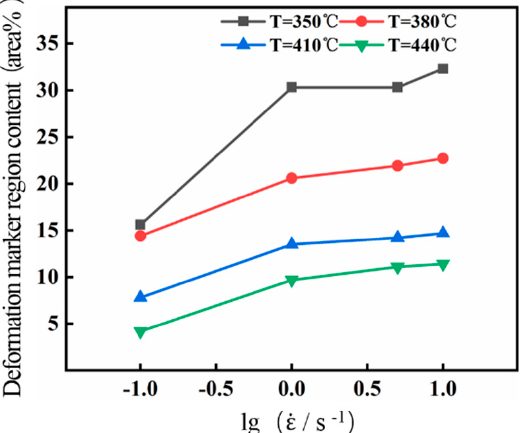
Figure 12. Statistics of the percentage of deformation marking area in the semi-solid CuSn10P1 alloy at different strain rates.